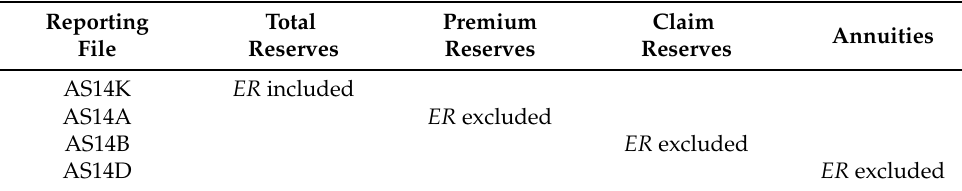
Table 3. Equalization reserves ( ER ) within the non-life’s files.